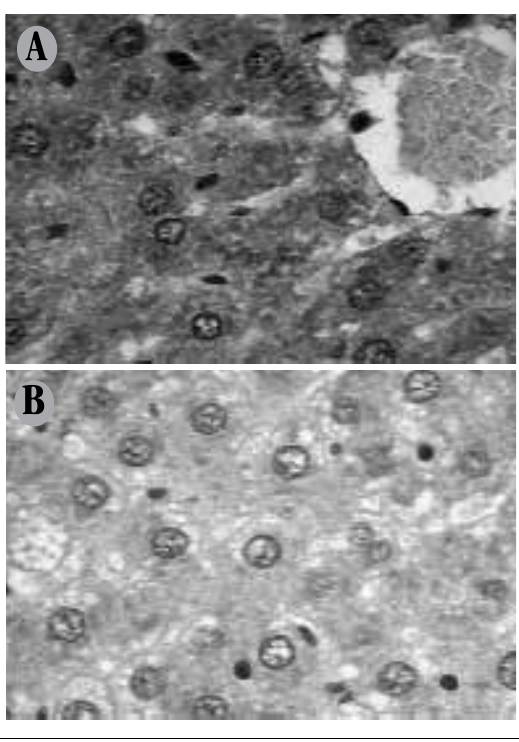
figurE 4 – Pattern of cytoplasmic immunostaining for liver insulin recepto A) animals of the control group (400×); B) high-fat diet